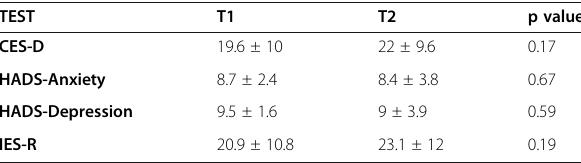
Table 2 (abstract A125). Results in the overall cohort of caregivers regarding tests for Depression, Anxiety and PTSD between videocalls